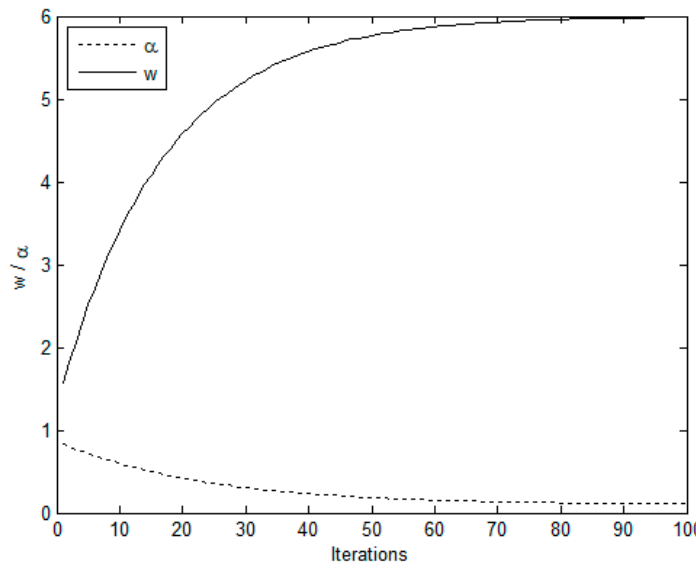
Figure 6. Cuves of α and w along with iterations.